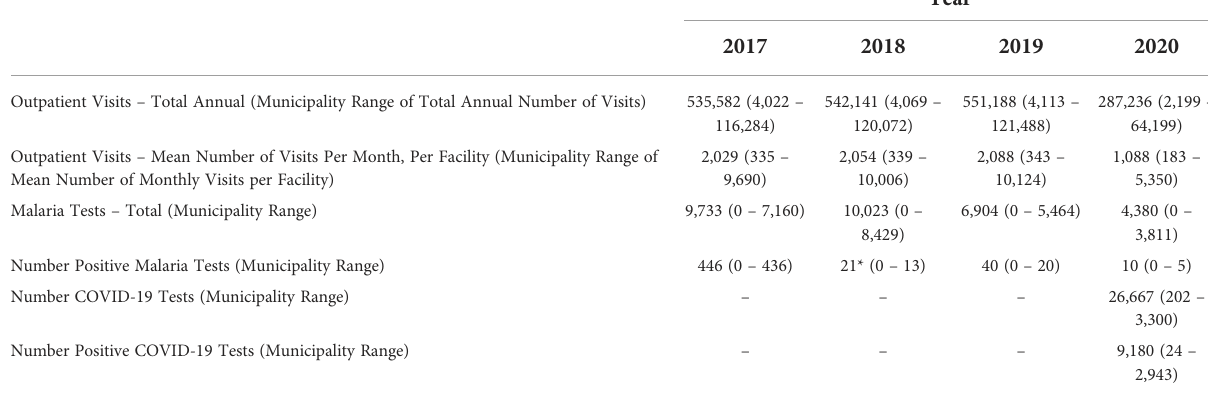
TABLE 1 Summary of the data on routine outpatient visits, malaria and COVID-19 testing and positivity aggregated from routinely collected data from Cabo Verde from January 2017 through December